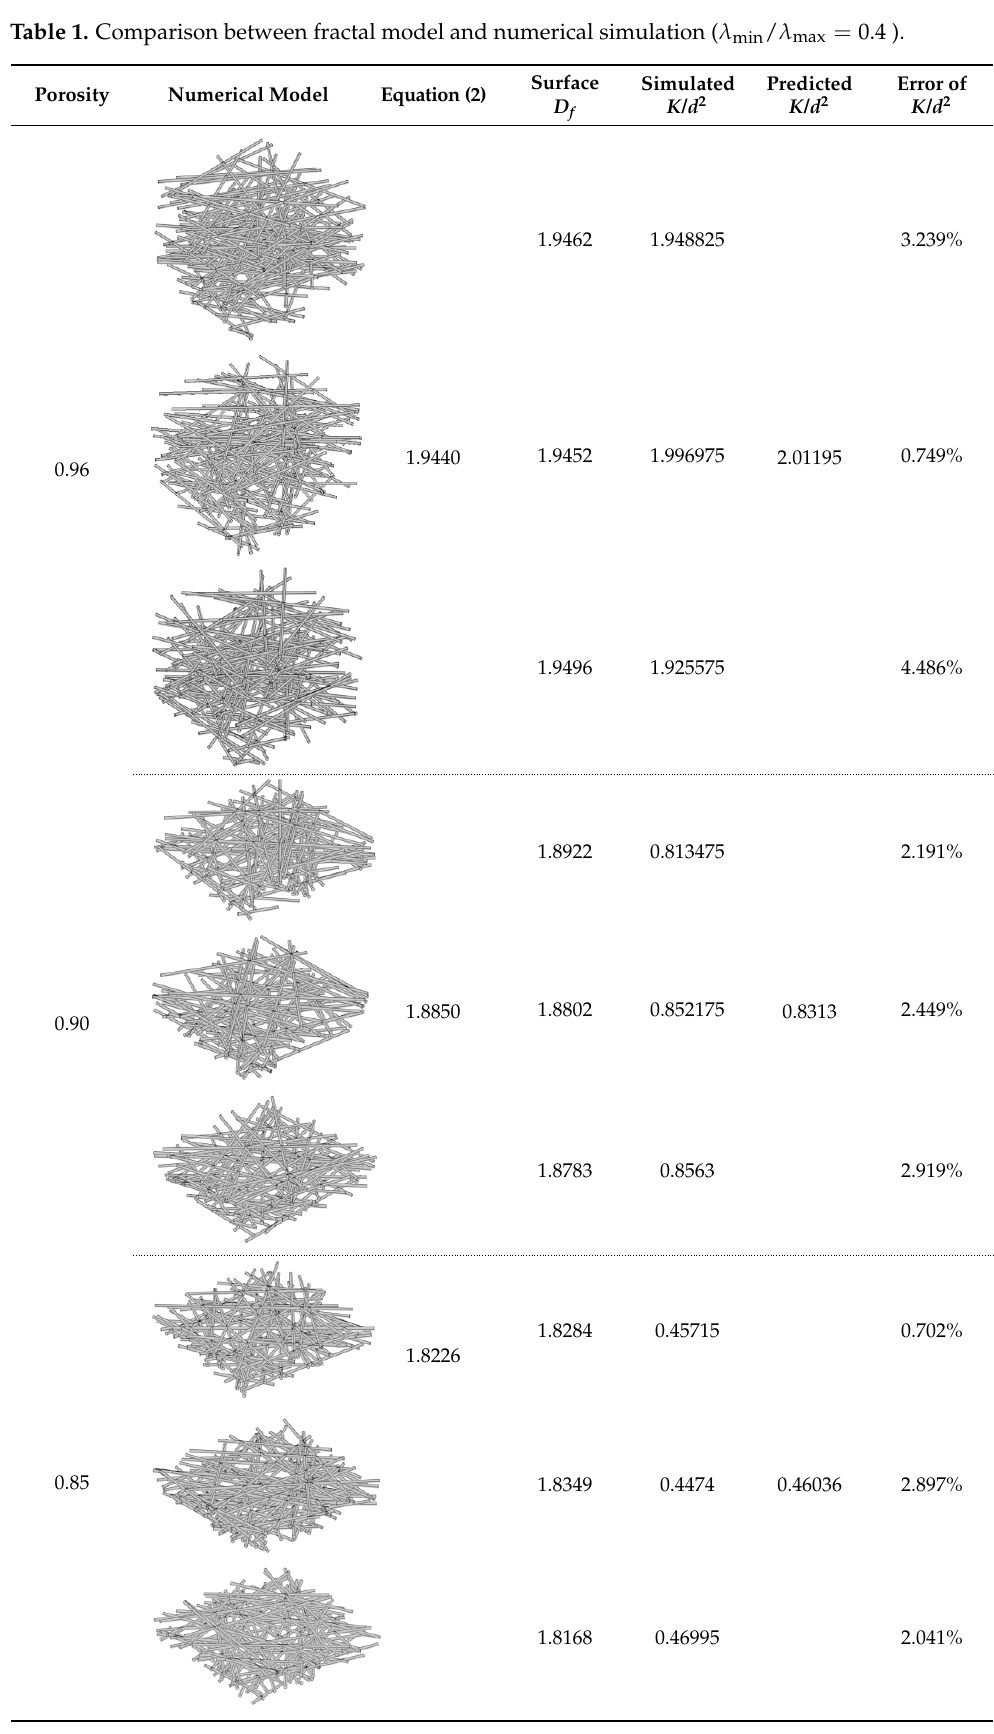
Table 1. Comparison between fractal model and numerical simulation ( λ min / λ max = 0.4 ).